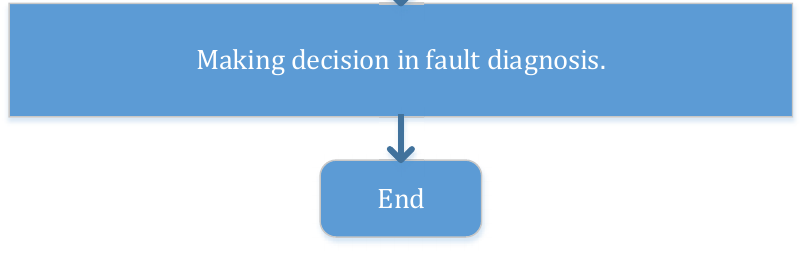
Figure 1. The flowchart of the new